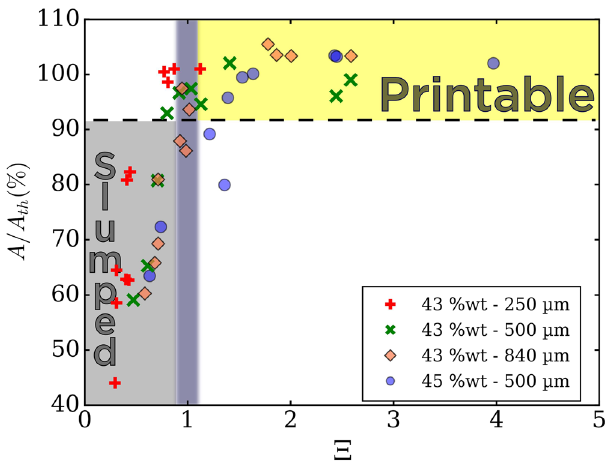
Figure 9. A / A th vs. Ξ of both boehmite suspensions and different nozzles sizes. Ξ = 1 establishes a clear limit of printability as all the points beyond have a shape fidelity higher than 90% (Printable region, in yellow). For Ξ < 1, the obtained objects are deformed and suspension is considered as non printable (Slumped region,